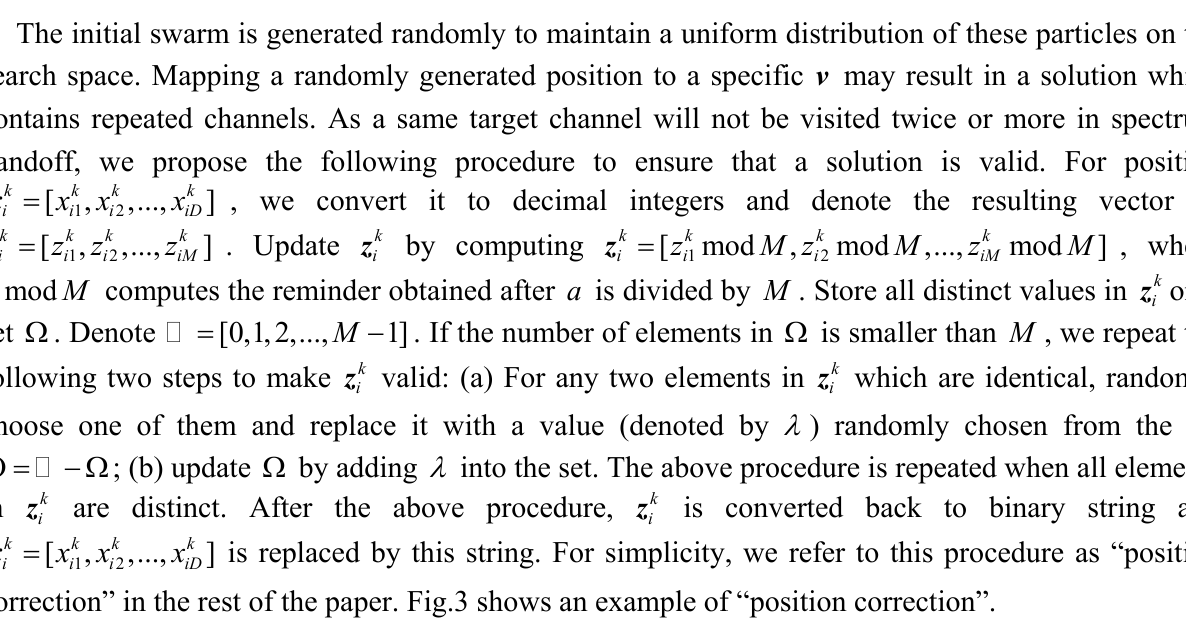
Figure 3. An example of “position correction” where 6 M =